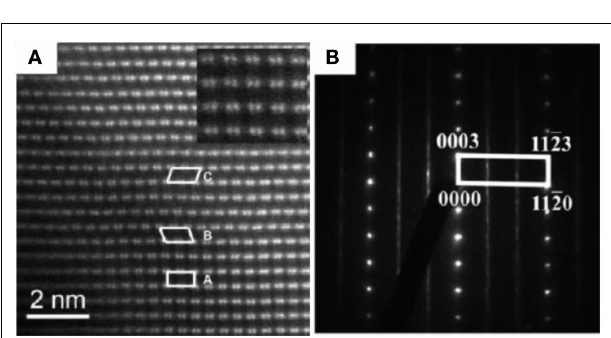
FIGURE 1 | Crystal models for (A) monoclinic and (B) hexagonal structures . Projecting lattice images to show the same and difference between these two structures. Green: Li; Blue: Ni; Purple: Mn; Red: O (Jarvis et al., 2011). Reprinted with permission from Jarvis et al. (2011). Copyright 2011 American Chemical Society.